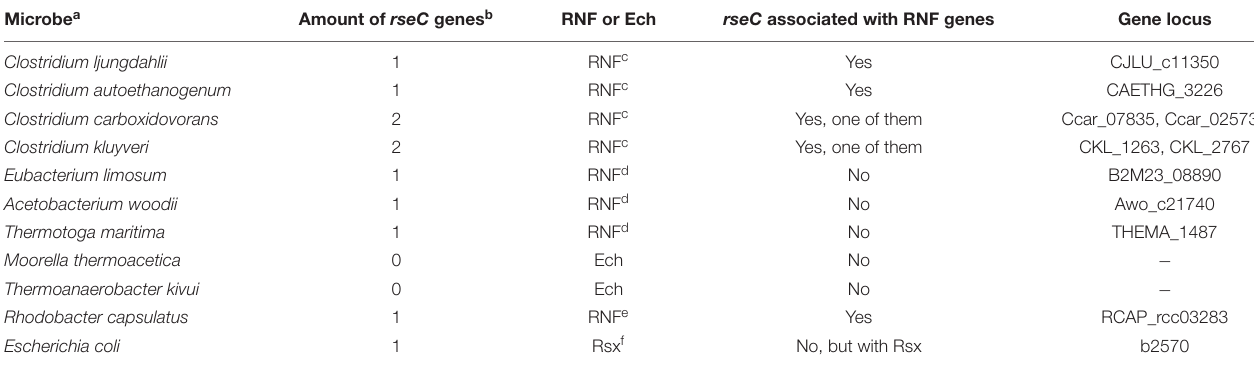
TABLE 3 | Distribution of rseC genes in model